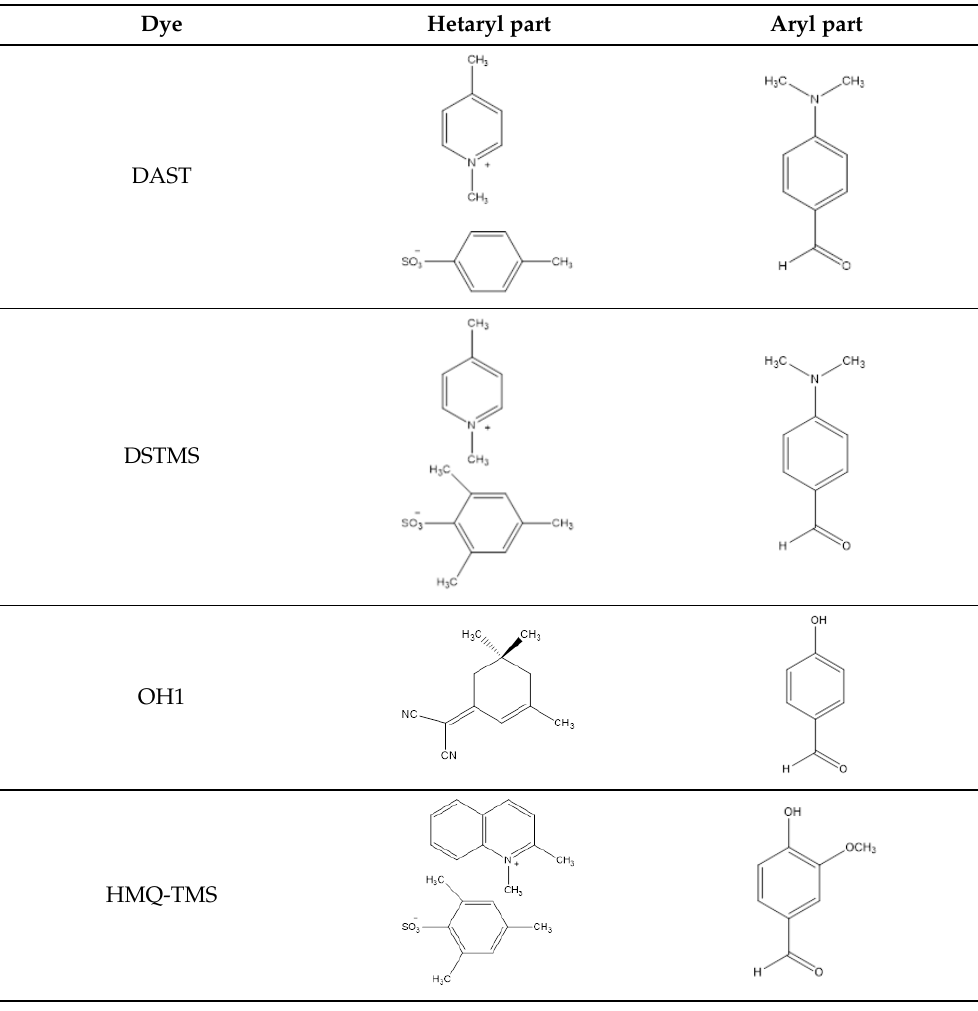
Table 4. Basic components for synthesis.